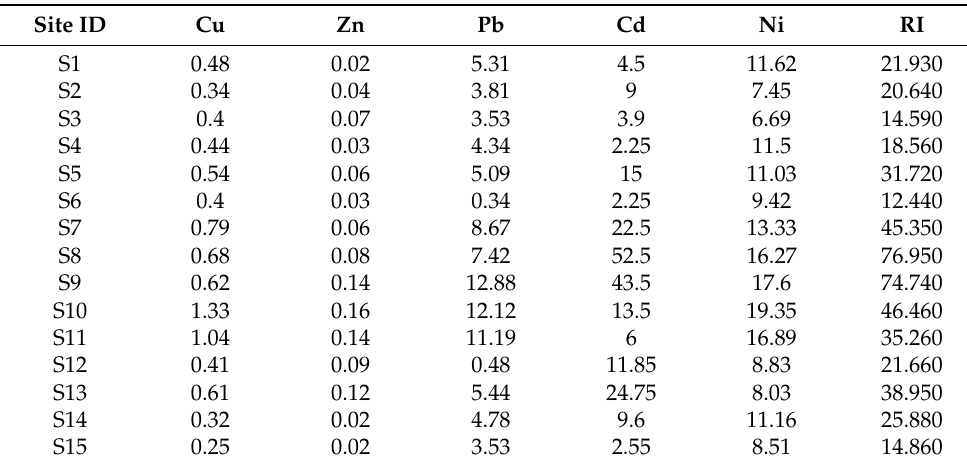
Table 6. Potential ecological risk and Risk index